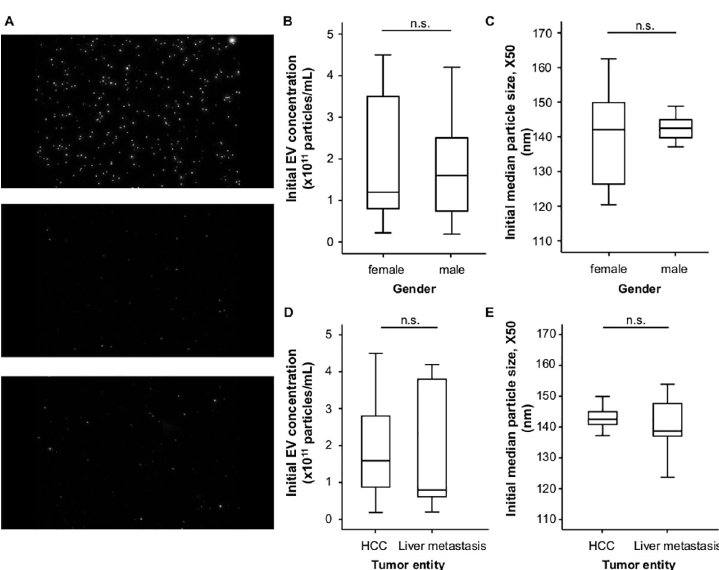
Fig 1. EVS concentration and size does not differ between female and male patients and between HCC and liver metastases before TACE. (A, up) NTA camera detection of a 1:250000 standard solution at the beginning of measurements. (A, middle) NTA camera view of a sample at baseline. (A, bottom) NTA camera view of a sample at d1 after TACE. (B) Initial EVs concentrations and (C) initial median particles sizes (X50) are comparable between female and male patients. (D) Initial EVS concentrations do not differ between patients with HCC and patients with liver metastases. (E) Initial median particle size (X50) does not differ between patients with HCC compared to patients with liver metastases.